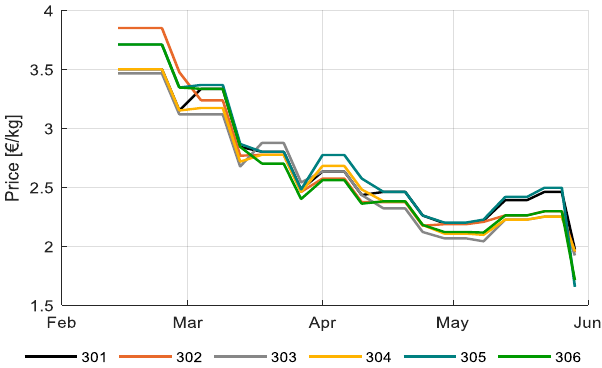
Figure A2. Realized tomato prices (€/kg) of different teams in different greenhouse compartments (301–306) during the harvesting period (13 February until 29 May 2020) based on their fruit quality (Brix).